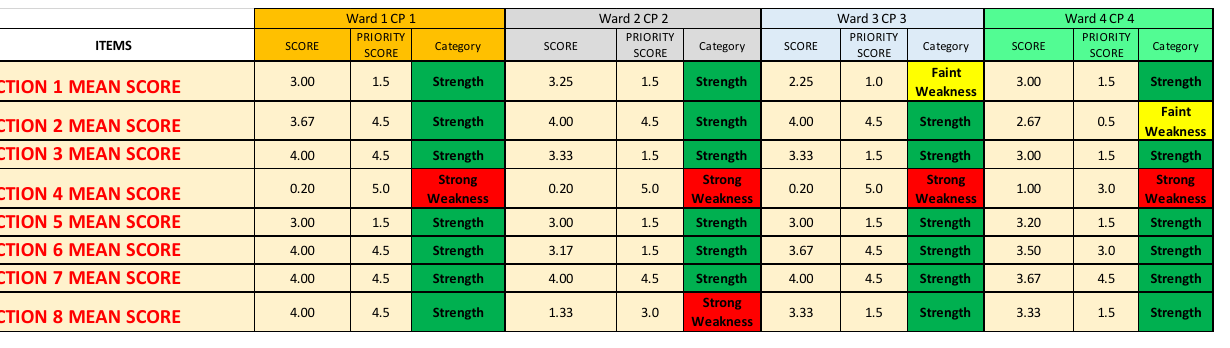
Figure 16. Summary of the results regarding all the Questionnaire Sections of the four wards analyzed, one for each CP.